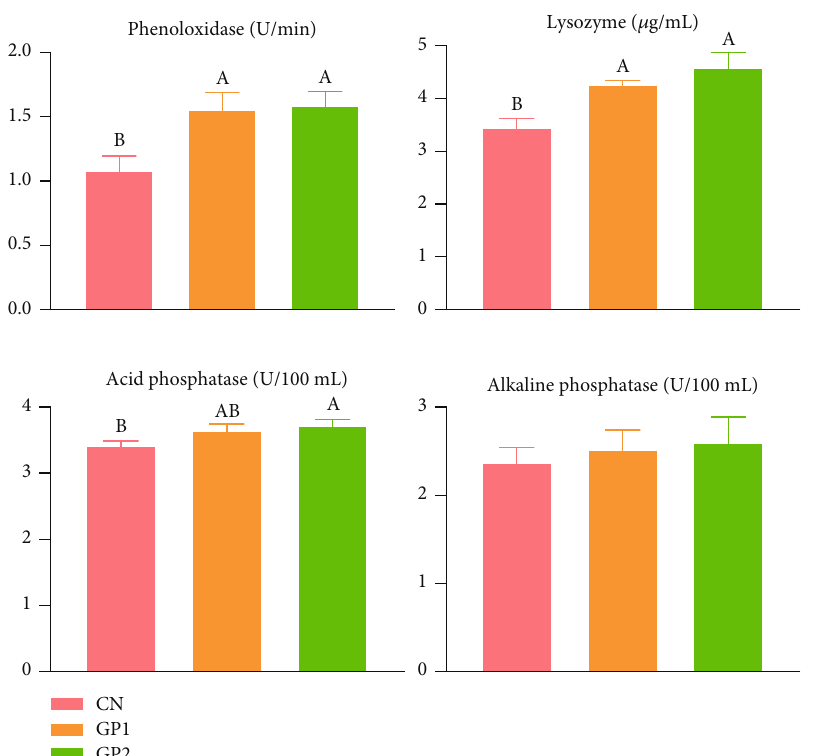
Figure 1: E ff ects of garlic powder inclusion on the serum immune indexes of Chinese mitten crabs. Bars assigned with di ff erent superscripts are signi fi cantly di ff erent ( P < 0 : 05 ); CN represents the control group that Chinese mitten crabs fed a basic diet; GP2 represents the group that the Chinese mitten crabs fed with 1000 mg/kg garlic powder in addition to the basic diet. GP2 represents the group that the Chinese mitten crabs fed with 2000mg/kg garlic powder in addition to the basic